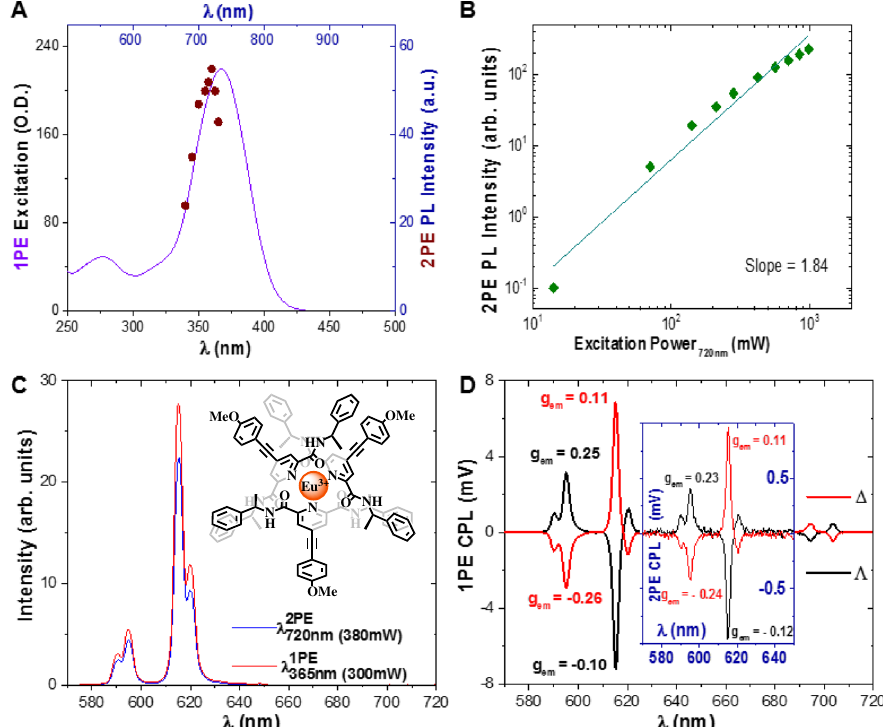
Fig. 1 Key photophysical parameters and spectra of Λ - and Δ -modi fi ed Eu:BPEPC in MeOH. A One photon excitation (solid purple line) and two-photon excitation (maroon dots) spectra ( λ em = 615nm) of modi fi ed Eu:BPEPC. B Excitation power dependency (green diamonds) of the 2PE induced photo luminescence (PL) intensity, slope 1.84±0.1, σ 2 = 144.5±3GM (10 − 50 cm 4 s/photon). C One ( λ ex = 365nm, solid red line) and two-photon ( λ ex = 720nm, solid blue line) induced emission spectrum of the depicted (insert) Λ - and Δ Eu:BPEPC. D One photon and (insert) two-photon CPL spectra of Λ - and Δ -modi fi ed Eu:BPEPC (solid black and red line respectively). Spectra recorded in MeOH.